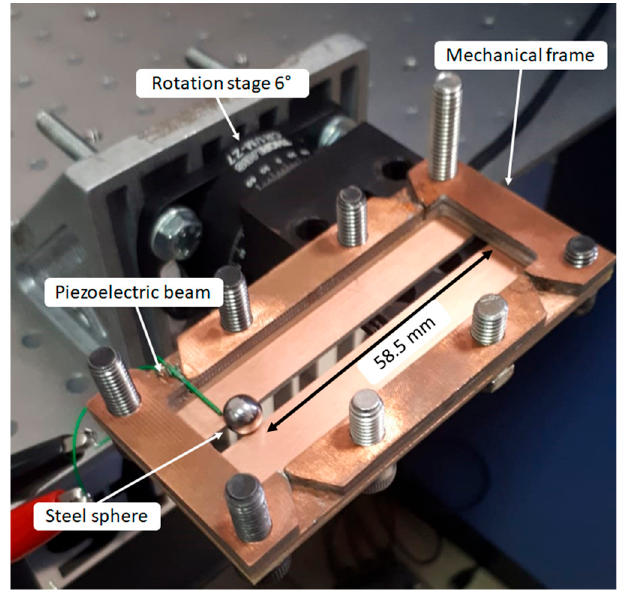
Figure 11. Experimental setup: mechanical frame installed on the rotation stage.